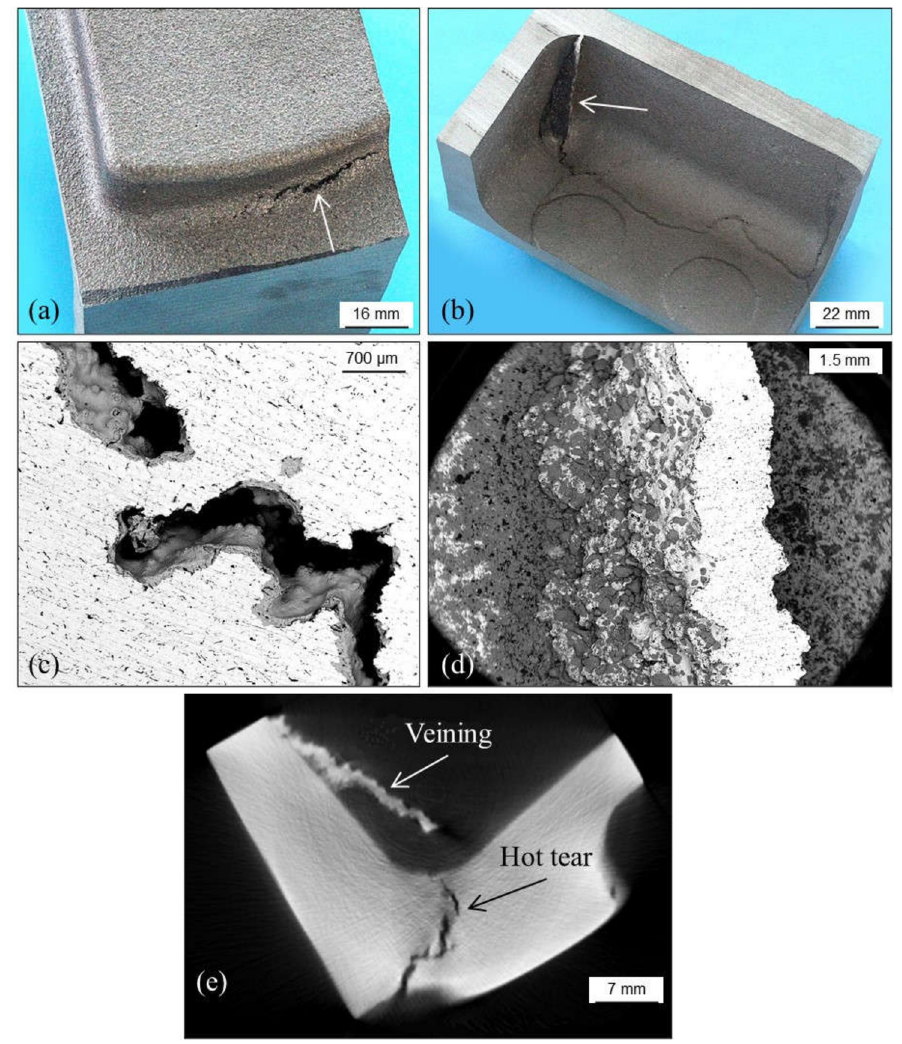
Figure 62. Concomitant hot tearing ( a , c ), and veining ( b , d ) defects found in a grey iron engine block. ( e ) X-ray tomography view of both